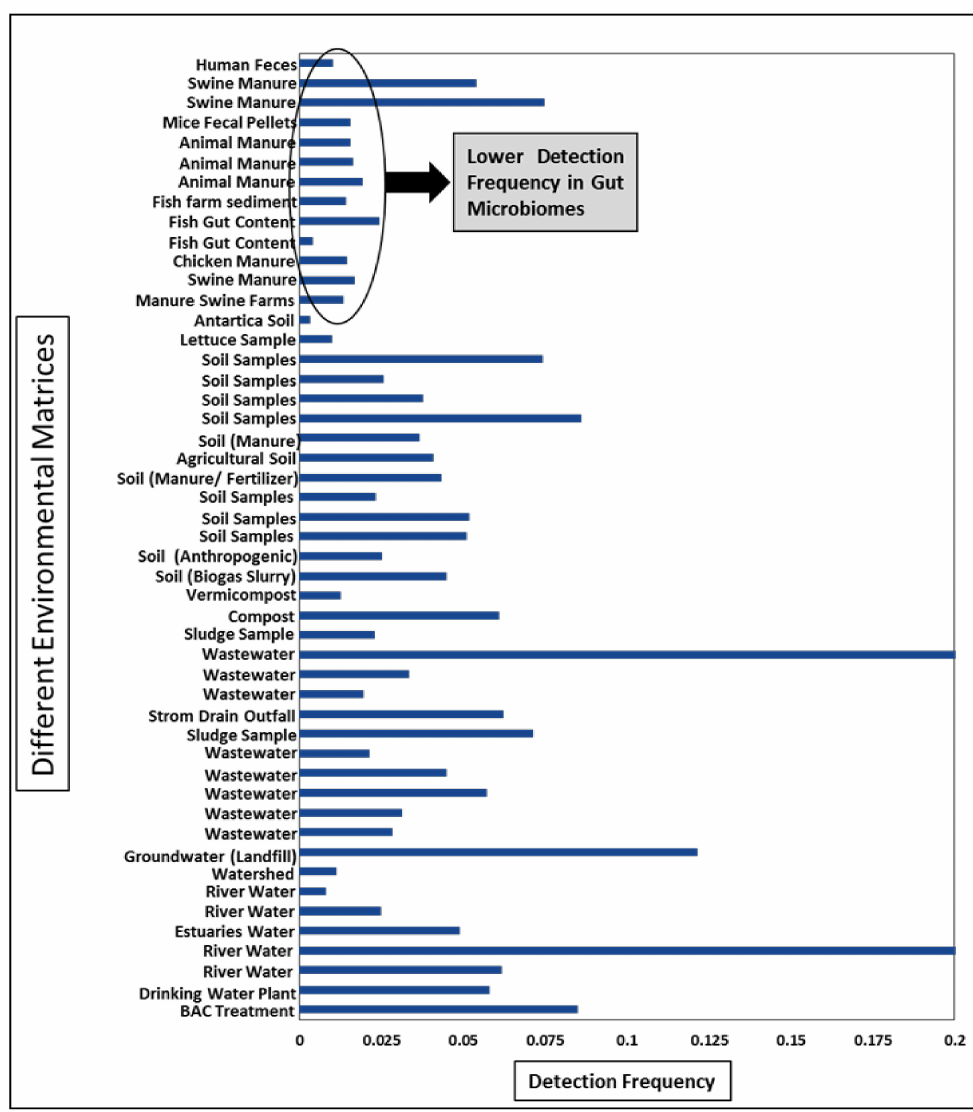
Figure 4. Detection Frequency of different environmental matrices from all included